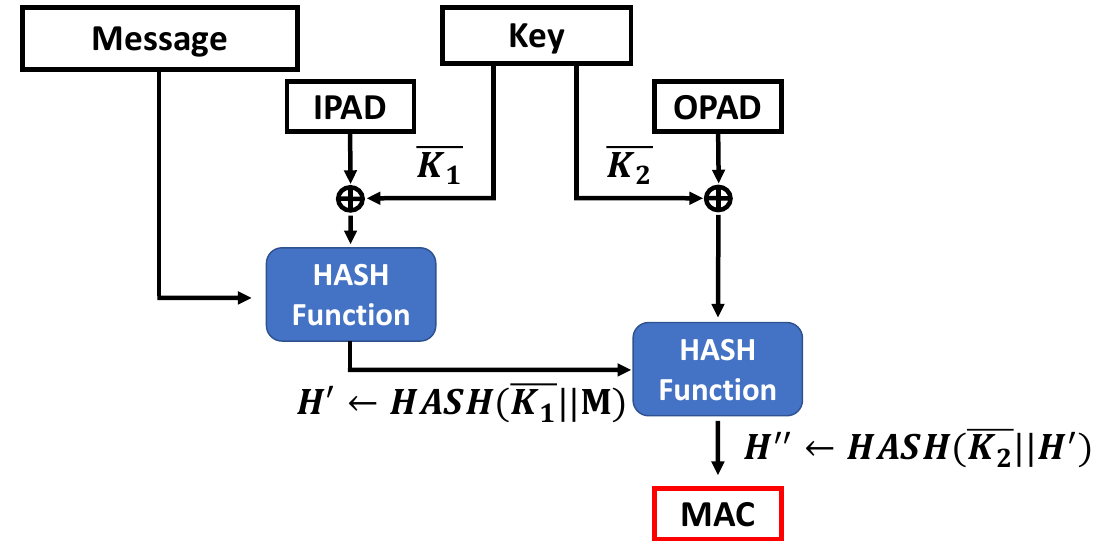
Figure 5. Hash Message Authentication Code (HMAC)